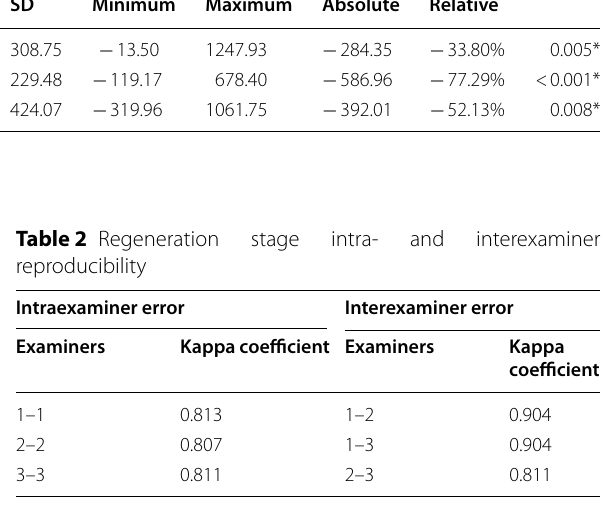
Table 1 Measurement of midpalatal suture bone density at T1 and T2